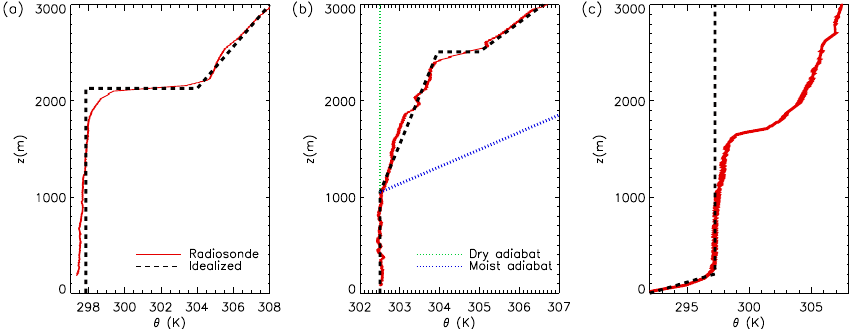
Fig. 11. Characteristic vertical potential temperature profiles for (a) a mixed layer, (b) a mixed layer topped with a conditionally unstable layer and (c) a stable boundary layer. In red an example from the radiosondes is presented, while in black an idealized profile is depicted. In (b) the profile of the potential temperature in the conditionally unstable layer is situated between the dry adiabat and the moist adiabat. In (c) a residual mixed layer from the previous day is present. The data is obtained at (a) 16:00LT on 17 July, (b) 18:00LT on 13 July and (c) 03:00LT on 7 August.